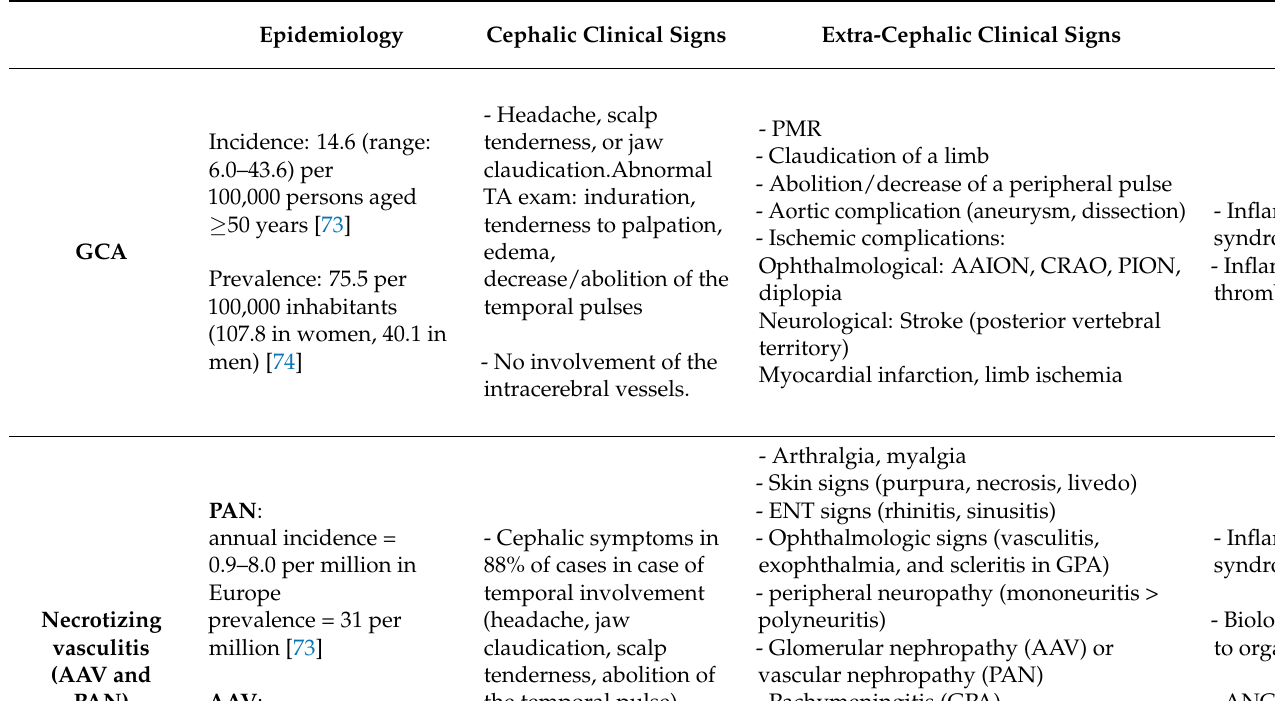
Table 1. Temporal